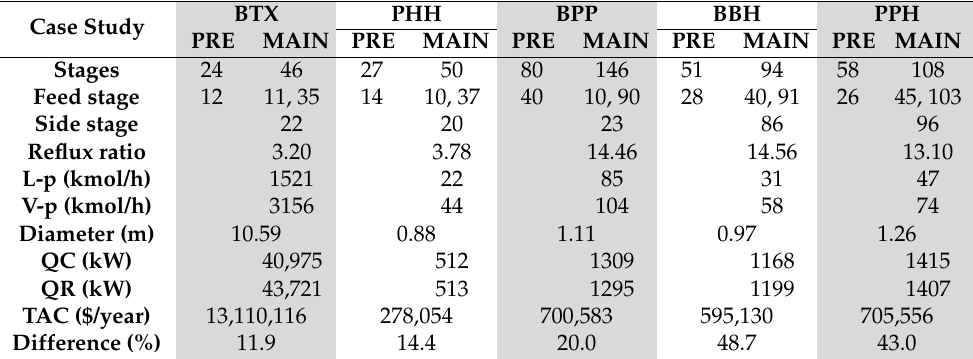
Table 7. Results for the designs obtained with the lower limit of the liquid